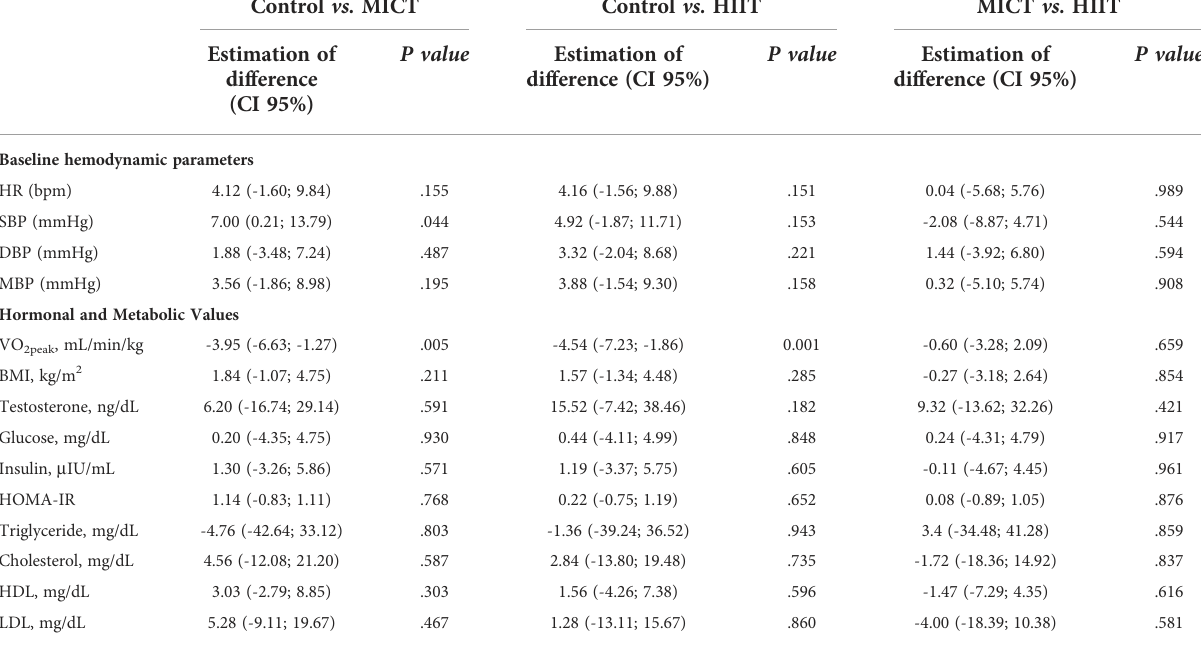
TABLE 3 Intergroup comparison of baseline hemodynamic, hormonal and metabolic parameters obtained after the 16-wk of physical training. Control vs.